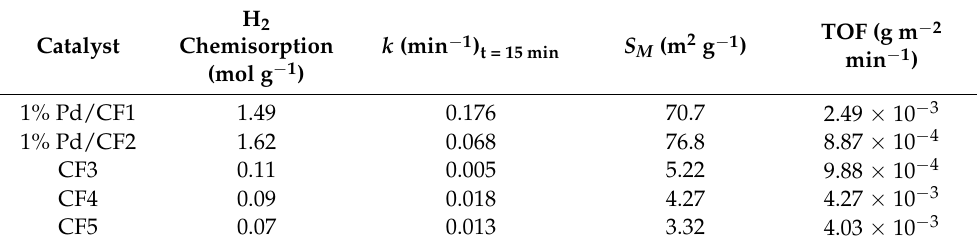
Table 4. Determination of TOF values for each Pd-CF catalyst in BrO 3 − reduction.